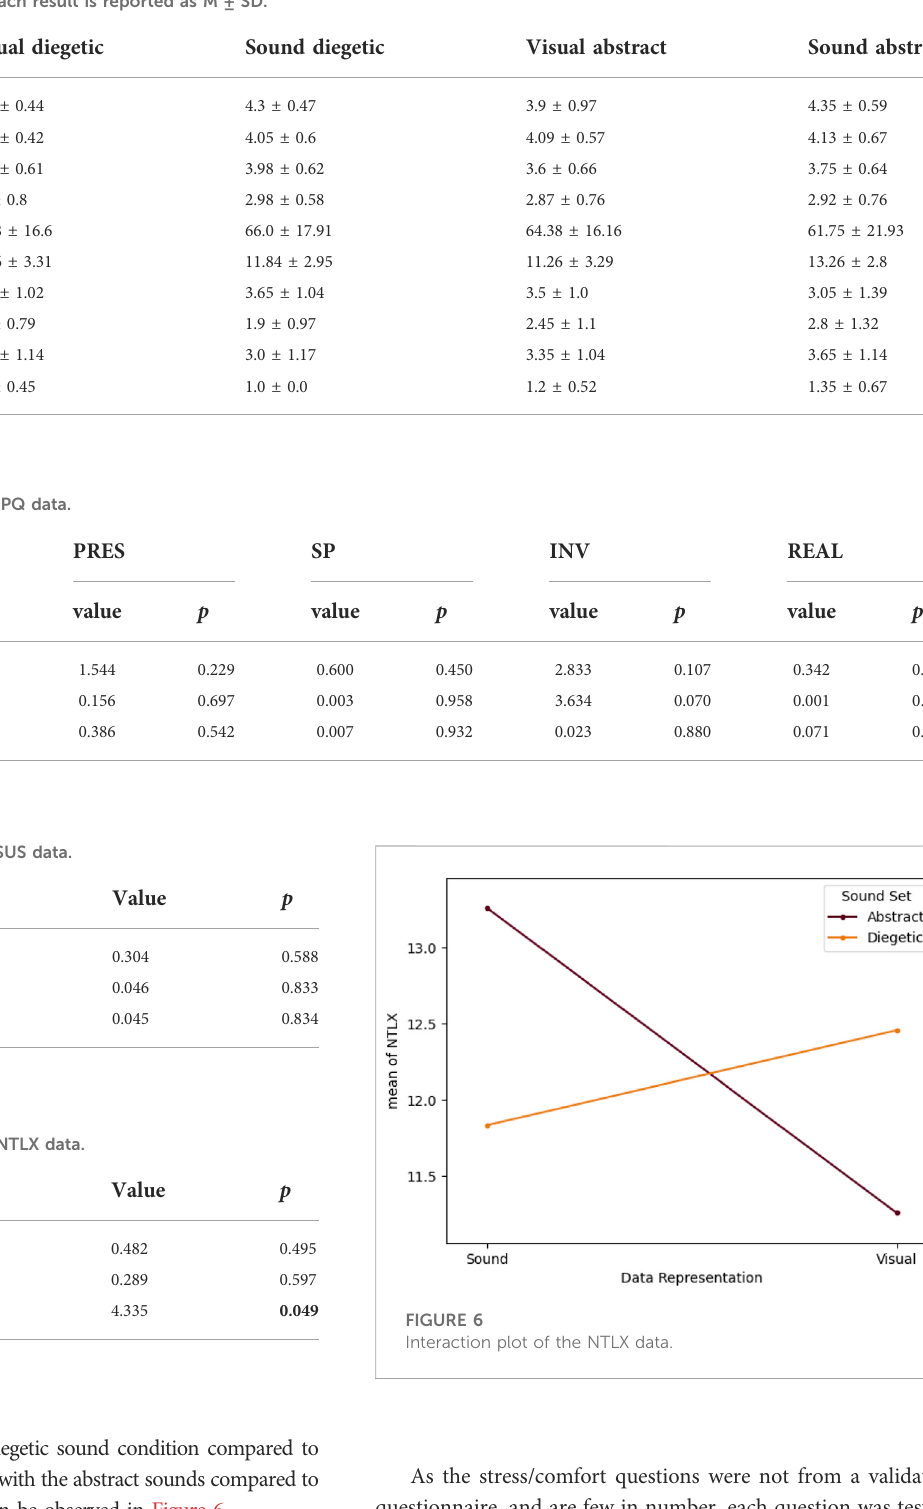
TABLE 5 Questionnaire Data. Each result is reported as M ± SD.